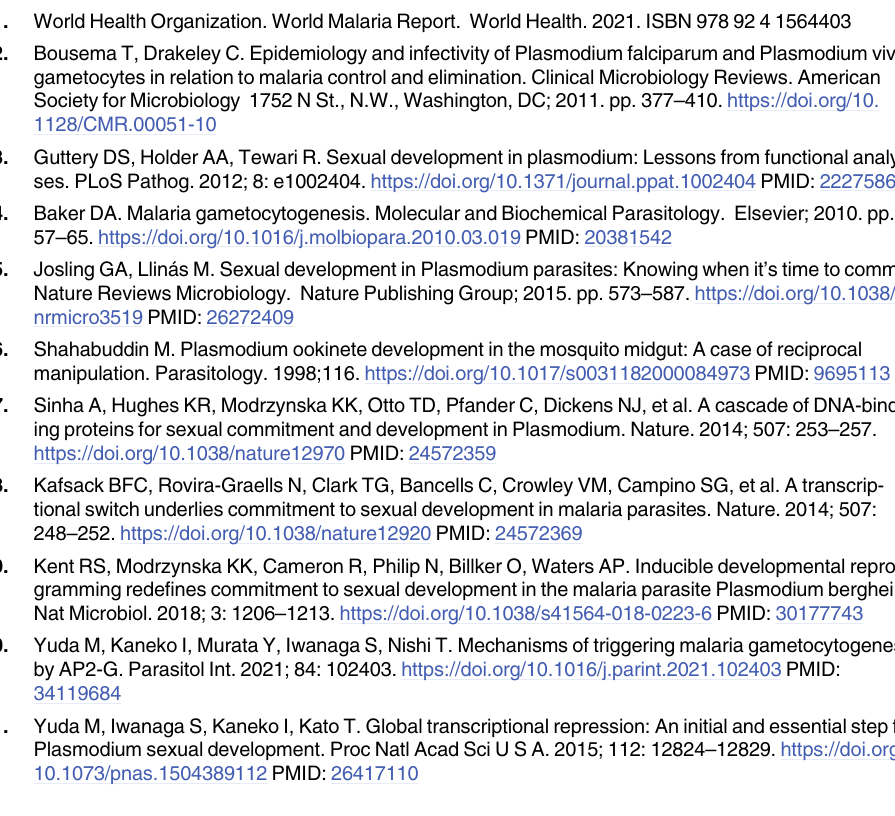
S5 Table. List of primers used in this